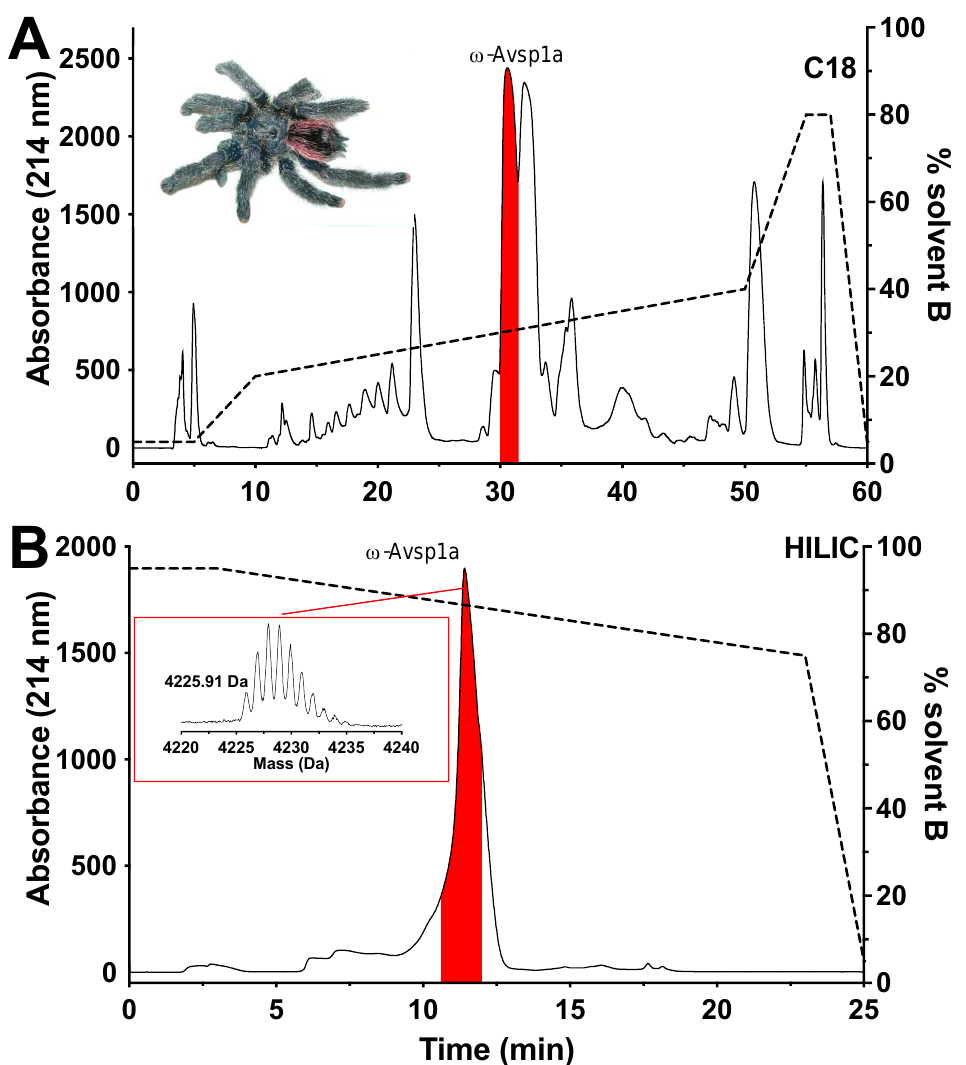
Figure 1. Isolation and purification of ω -Avsp1a. ( A ) Chromatogram resulting from fractionation of crude venom from Avicularia spec. (“Amazonas Purple”, Peru; inset shows photo of representative specimen by V.H.) using C 18 RP-HPLC. ( B ) Chromatogram resulting from further purification of the red fraction shown in panel A using HILIC-HPLC. Inset shows a MALDI-MS spectrum of purified ω -Avsp1a with the molecular mass indicated as [M + H] + . The dashed line indicates the gradient of solvent B (90% ACN/0.05% TFA). The red peak contains the peptide ω -Avsp1a that is active on Ca V 3.